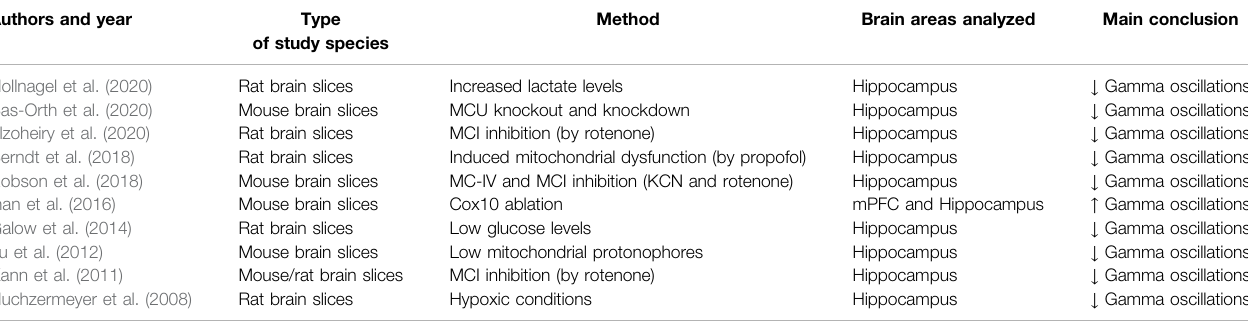
TABLE 1 | Results from systematic search on literature (PubMed) of the following keywords: Mitochondria AND Gamma oscillations. Only data that directly investigated the effect that mitochondrial/metabolic impairments exert on gamma oscillations have been included, criterion assessed based on information illustrated in titles/abstracts. Authors and year